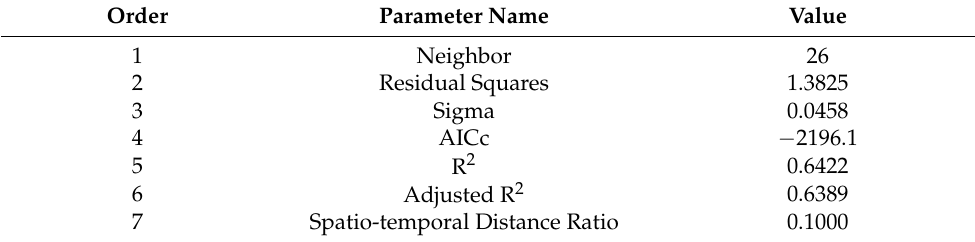
Table 8. Parameters associated with